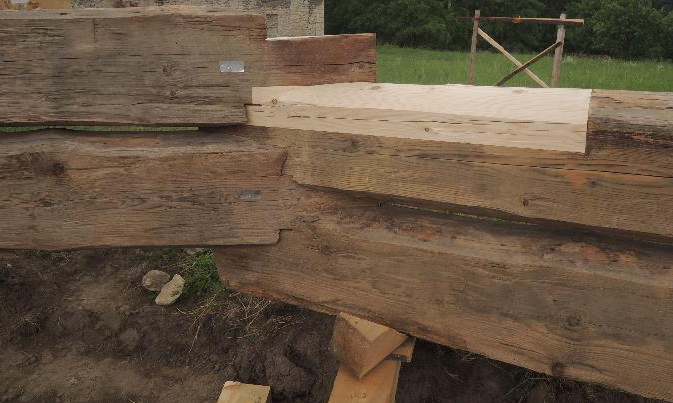
Figure 32. The repaired beam put back to its original place in the barn timber wall (inside view).